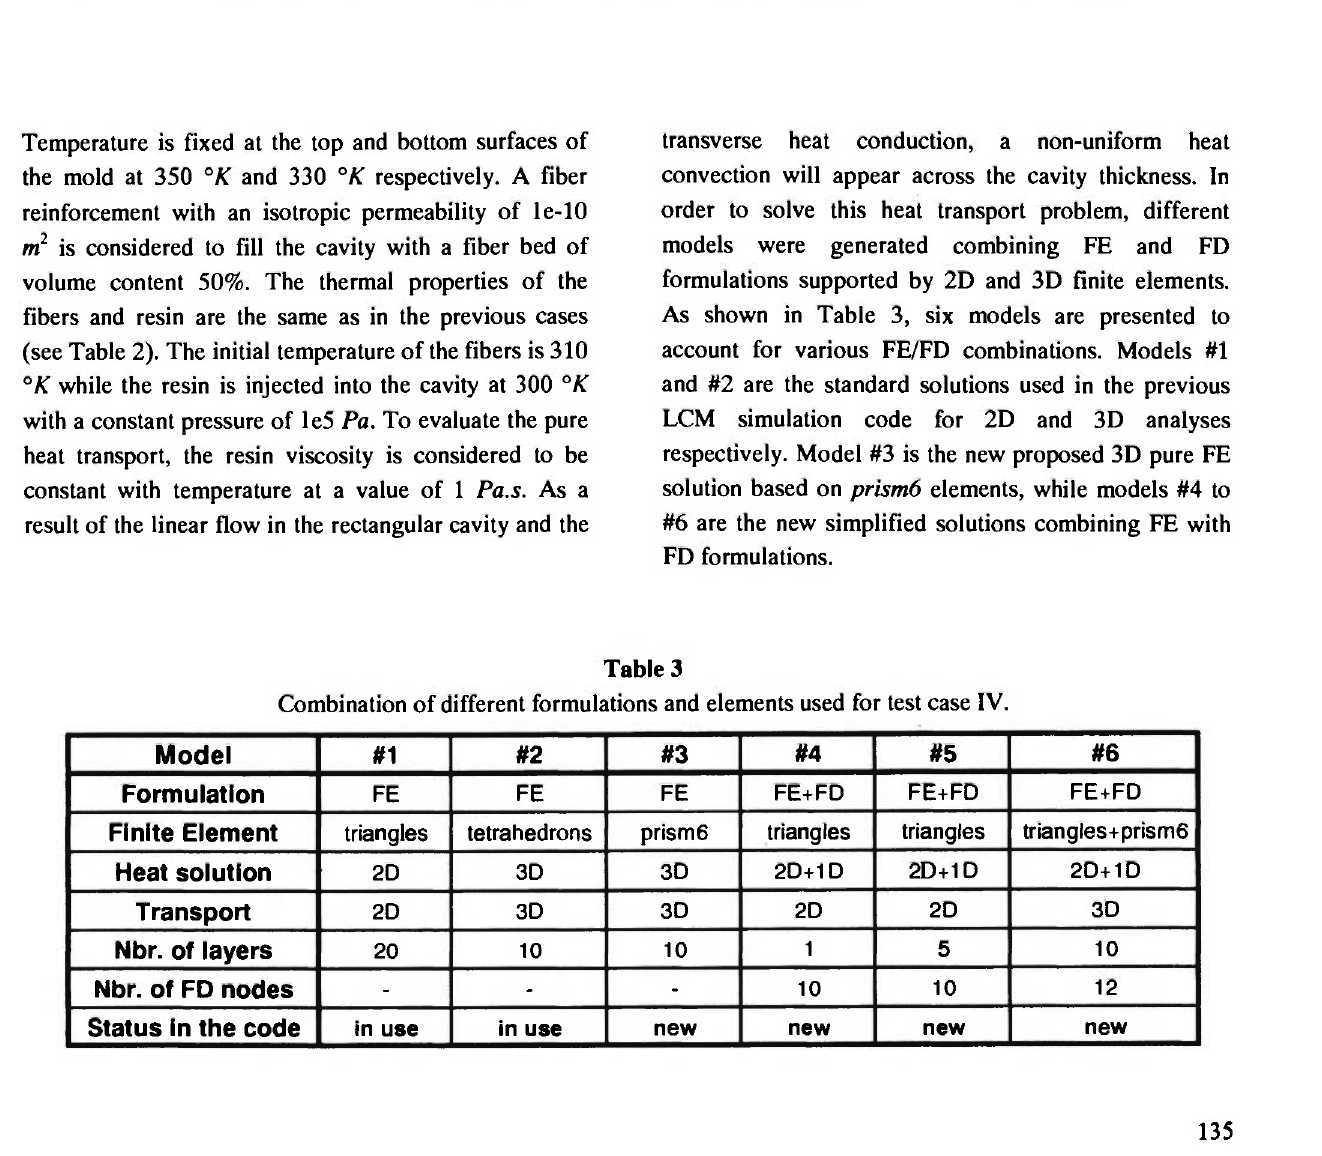
Fig. 19: Rectangular cavity used for the 2D convection test with different top and bottom mold wall temperatures.